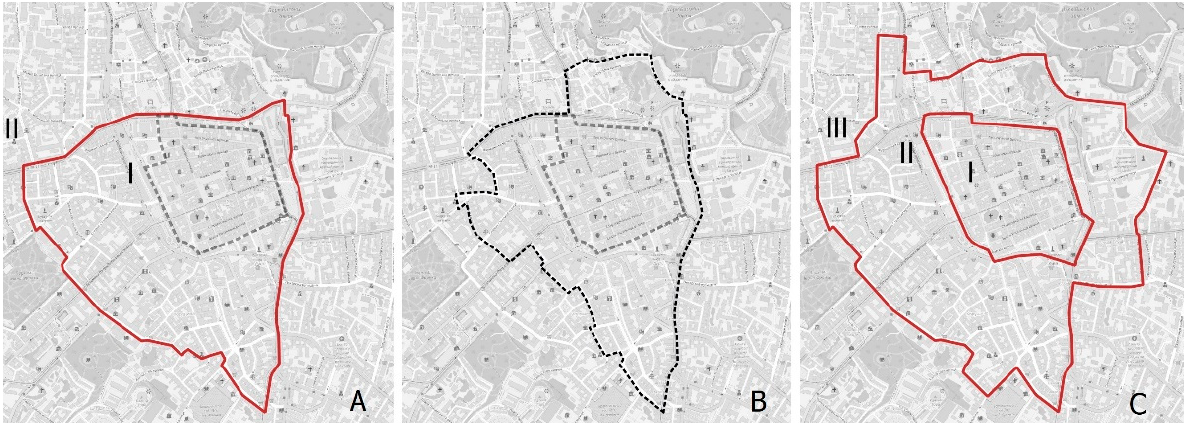
Figure 2. Scheme of expansion of parking zones in the center of Lviv: ( A ) parking zones and the pedestrian area in 2016 [51]; ( B ) proposal for a short-term entry zone (2016) within which the study was conducted [20]; ( C ) parking zones in 2021 [52]. Schemes by R. Liubytskyi.